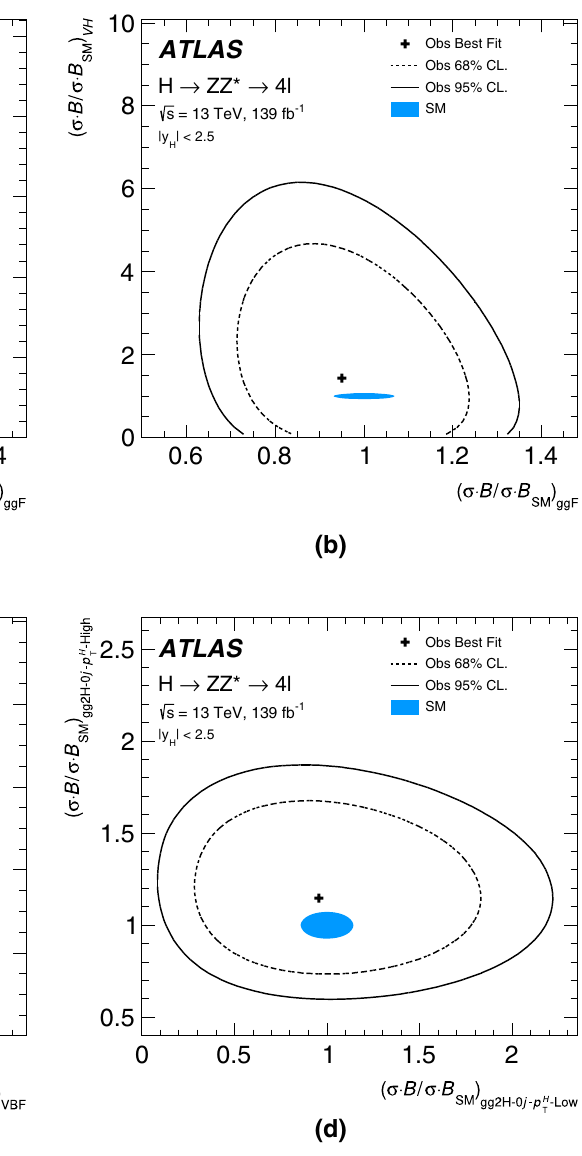
Fig. 11 Likelihood contours at 68% CL (dashed line) and 95% CL (solid line) in the ( a ) (ggF, VBF), ( b ) (ggF, VH ), ( c ) (VBF, VH ) and ( d ) (gg2H-0 j - p H -Low, gg2H-0 j - p H -High) plane. The SM prediction T T